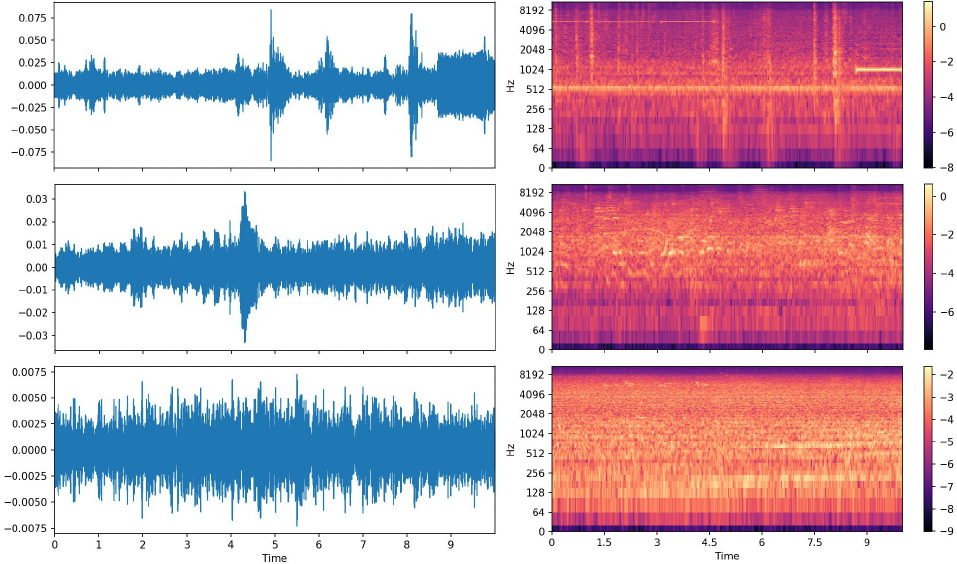
Figure 12. The 10-second audio clips from DCASE’20 Low Complexity ASC [31]. Left : the raw waveform data. Right : the corresponding log Mel spectrogram. The acoustic scenes from top to down: transportation (traveling by tram), indoor (metro station), outdoor